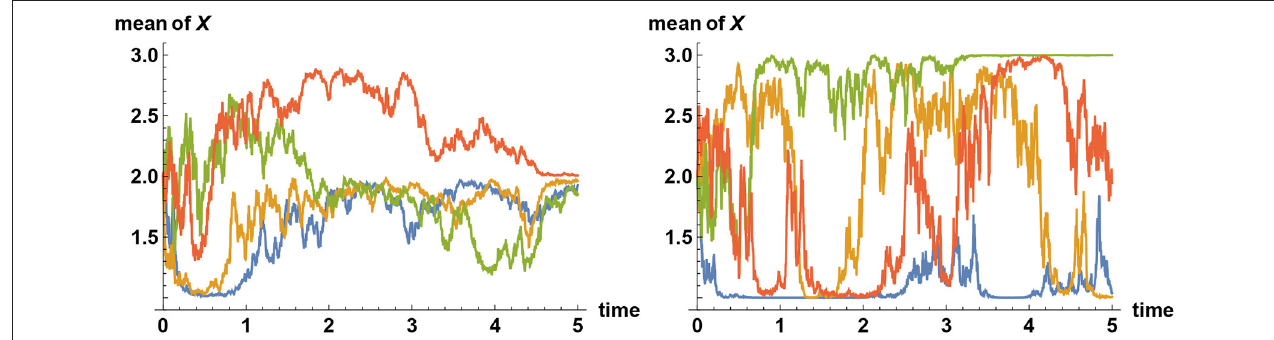
FIGURE 5 | Simulating alternative fact. Three alternatives are represented by the values X 1, X 2, and X 3. Plotted here are sample paths for the mean values = = = σ Xt ǫ t , where σ ǫ t of X subject to information process ξ t 2 and denotes Brownian noise. In all simulations, the simulator has chosen the alternative X 2 to = + = { } = be the correct one. On the left panel, all decision makers start with the prior belief that the probability of X 2 is only 10%, whereas the two other alternatives are = equally likely realized at 45% each. Hence the initial mean of X equals 2. Initially, their views tend to converge either to X 1 or X 3; but over time, sufficient facts = = are revealed that they all converge to the correct choice made by the simulator. But what if they do not believe in the “truth” at all? On the right panel, the simulator has again chosen X 2 to represent the true value, but the decision makers assume that this is impossible and that the two other alternatives are equally likely realized at = 50% each. Hence again the initial mean of X equals 2. In this case, the decision makers’ views tend to converge quickly to one of the two “false” alternatives X 1 or = X 3. These two beliefs are, however, only quasi-stable; the views will never converge indefinitely. Instead, their views tend to flip back and forth between the = alternatives X 1 and X 3, but never converging to either one, and certainly never come close to the correct alternative X = = =